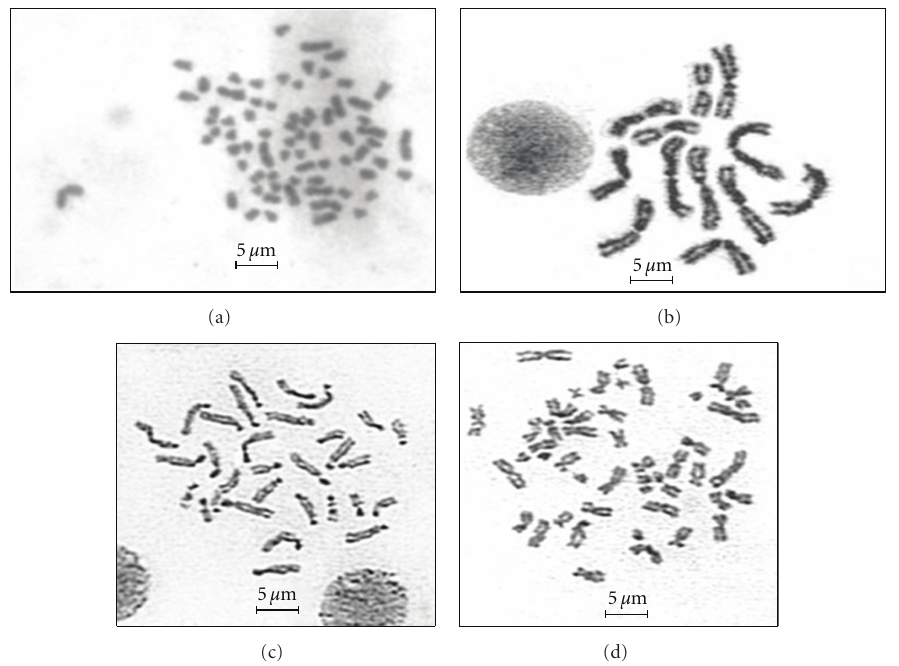
Figure 3: Metaphasic plates representing the di ff erent chromosome patterns found in Pachycondyla species. (a) Pachycondyla impressa , 2 n = 70, karyotype with a high number of chromosomes, mostly acrocentric. (b) Pachycondyla unidentata , 2 n = 12, karyotype with a low number of chromosomes, comprised exclusively by type M chromosomes of large size. (c) Pachycondyla arhuaca , 2 n = 36, Karyotype comprised exclusively by type A chromosomes. (d) Pachycondyla venusta , 2 n = 54, Karyotype comprised by types A and M chromosomes, a pattern found in many species and very common in the Neoponera group.